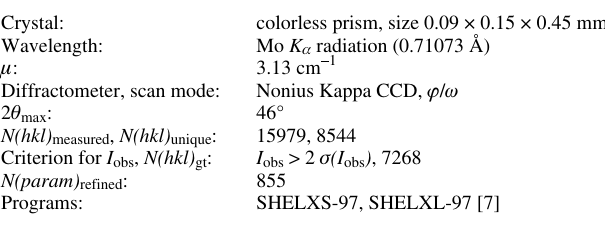
Table 1. Data collection and